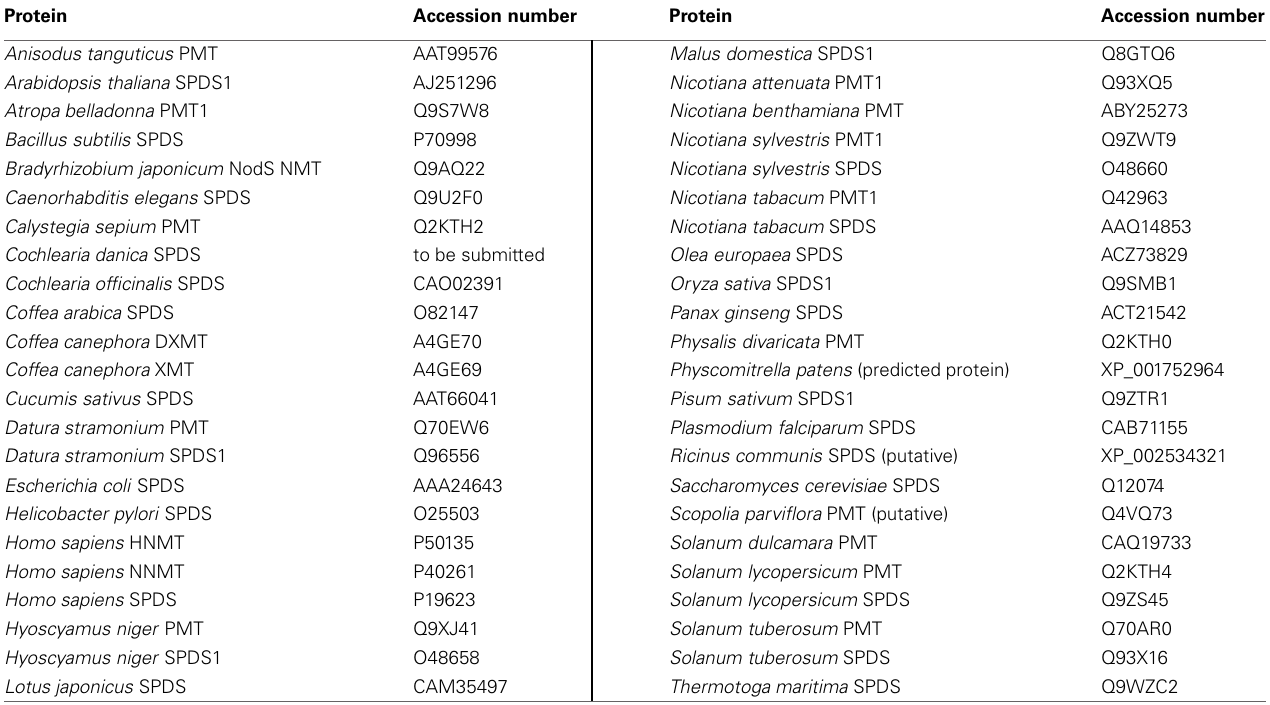
Table 3 | Accession numbers of sequences used for the phylogenetic tree in alphabetical order. Protein